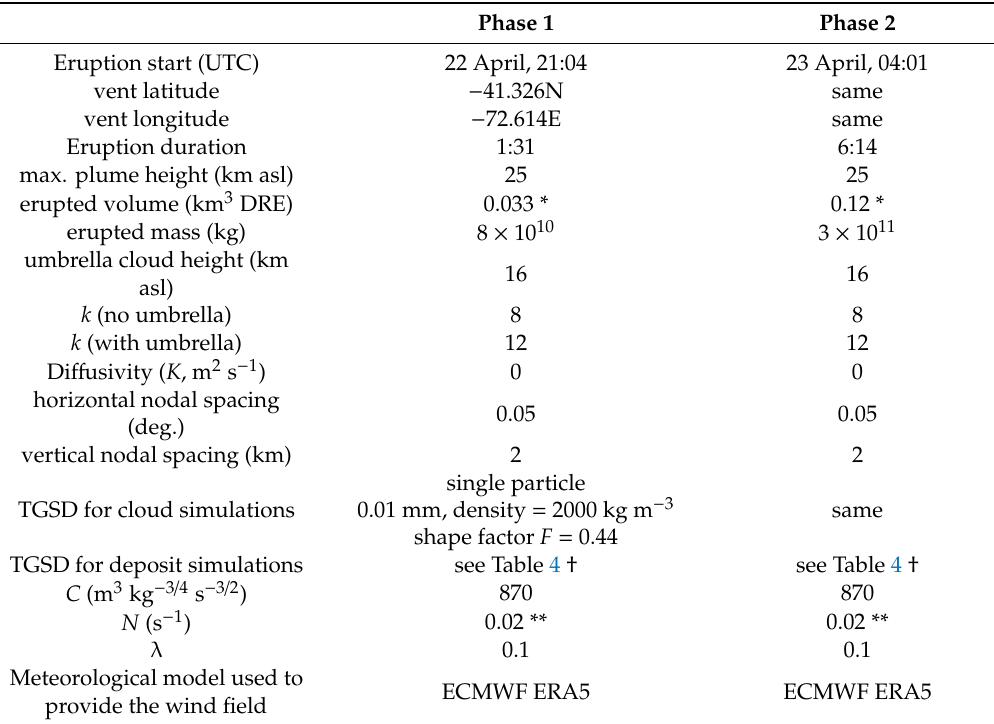
Table 3. Inputs to Calbuco model simulations. Eruption start times and durations are taken from observations reported in Van Eaton, et al. [9]. Phase